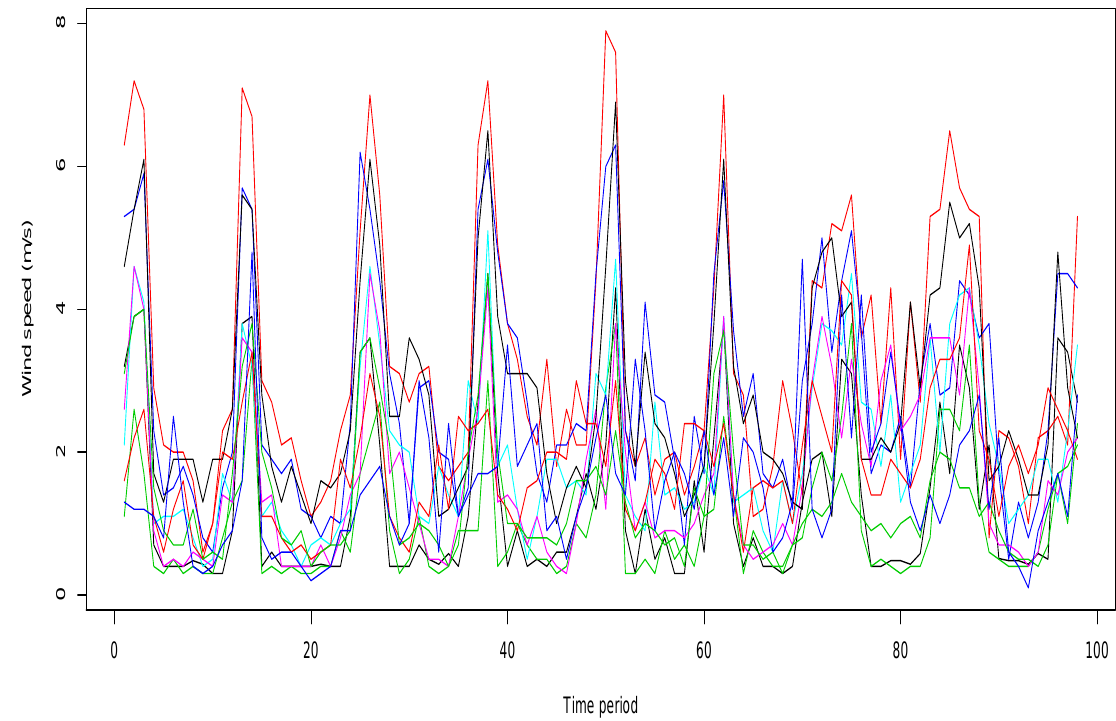
Figure 2. WS values (in m/s) of ten air quality monitoring stations in the Bogotá area (data at each monitoring station were collected each two hours between 26 January 2011 at 10:00 a.m. to 3 February 2011 at 12:00 p.m.). In total, WS data were collected in 98 time periods (time period 1 corresponds to 10:00 a.m. of 26 January 2011 and time period 98 to 12:00 p.m. 3 February